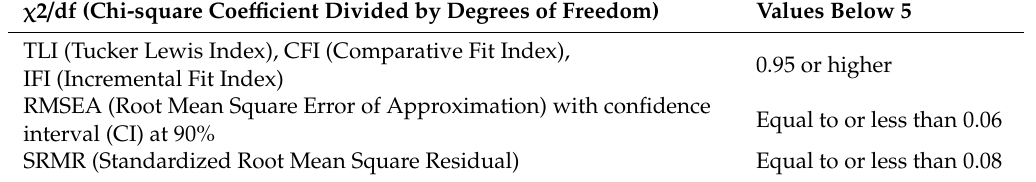
Table 1. Adjustment Indexes.